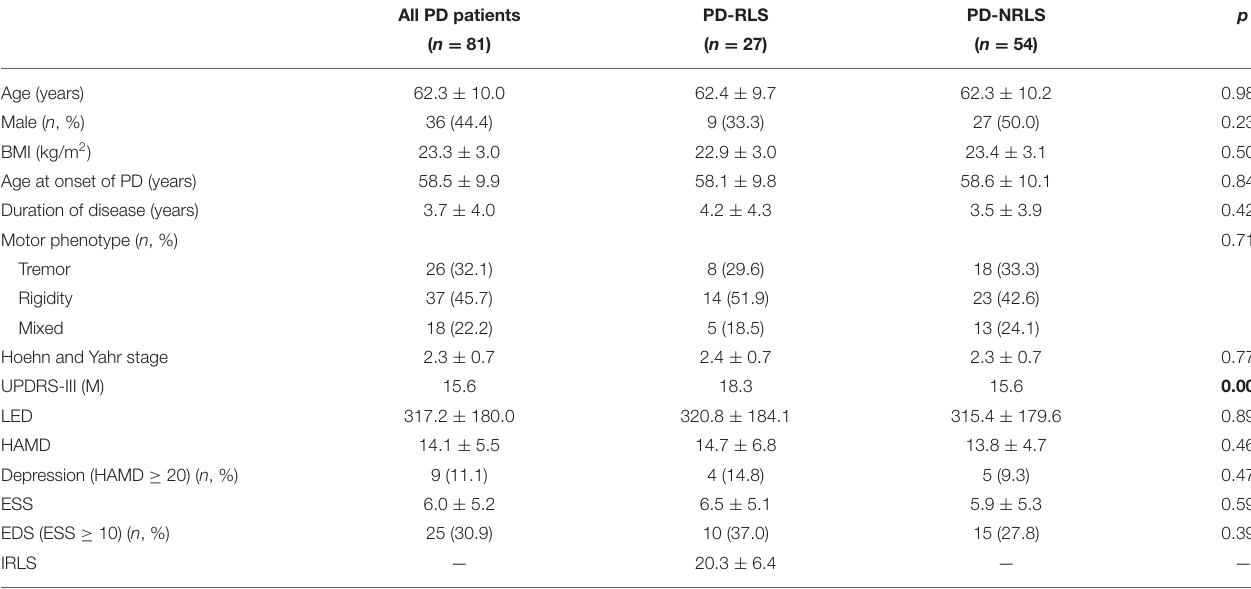
TABLE 1 | Demographic and clinical characteristics of PD patients with and without RLS.